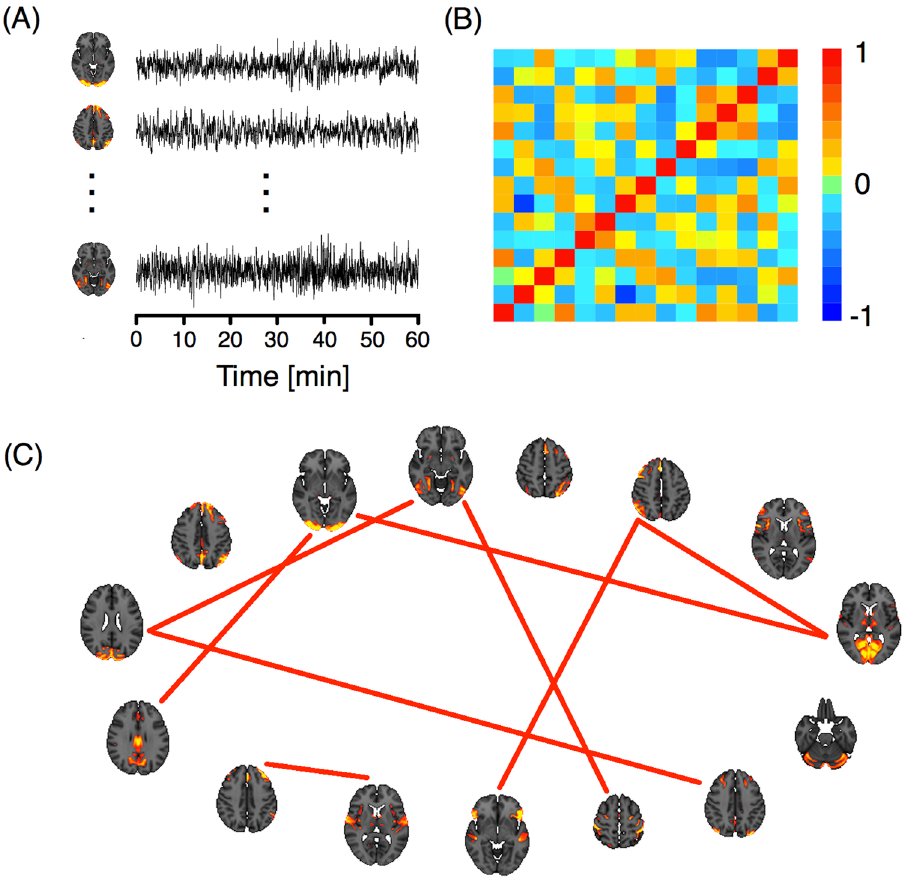
Figure 4. ( A ) ICA components and their corresponding time series. ( B ) Correlation matrix of the time series. ( C ) Network representation. The links correspond to the nine highest